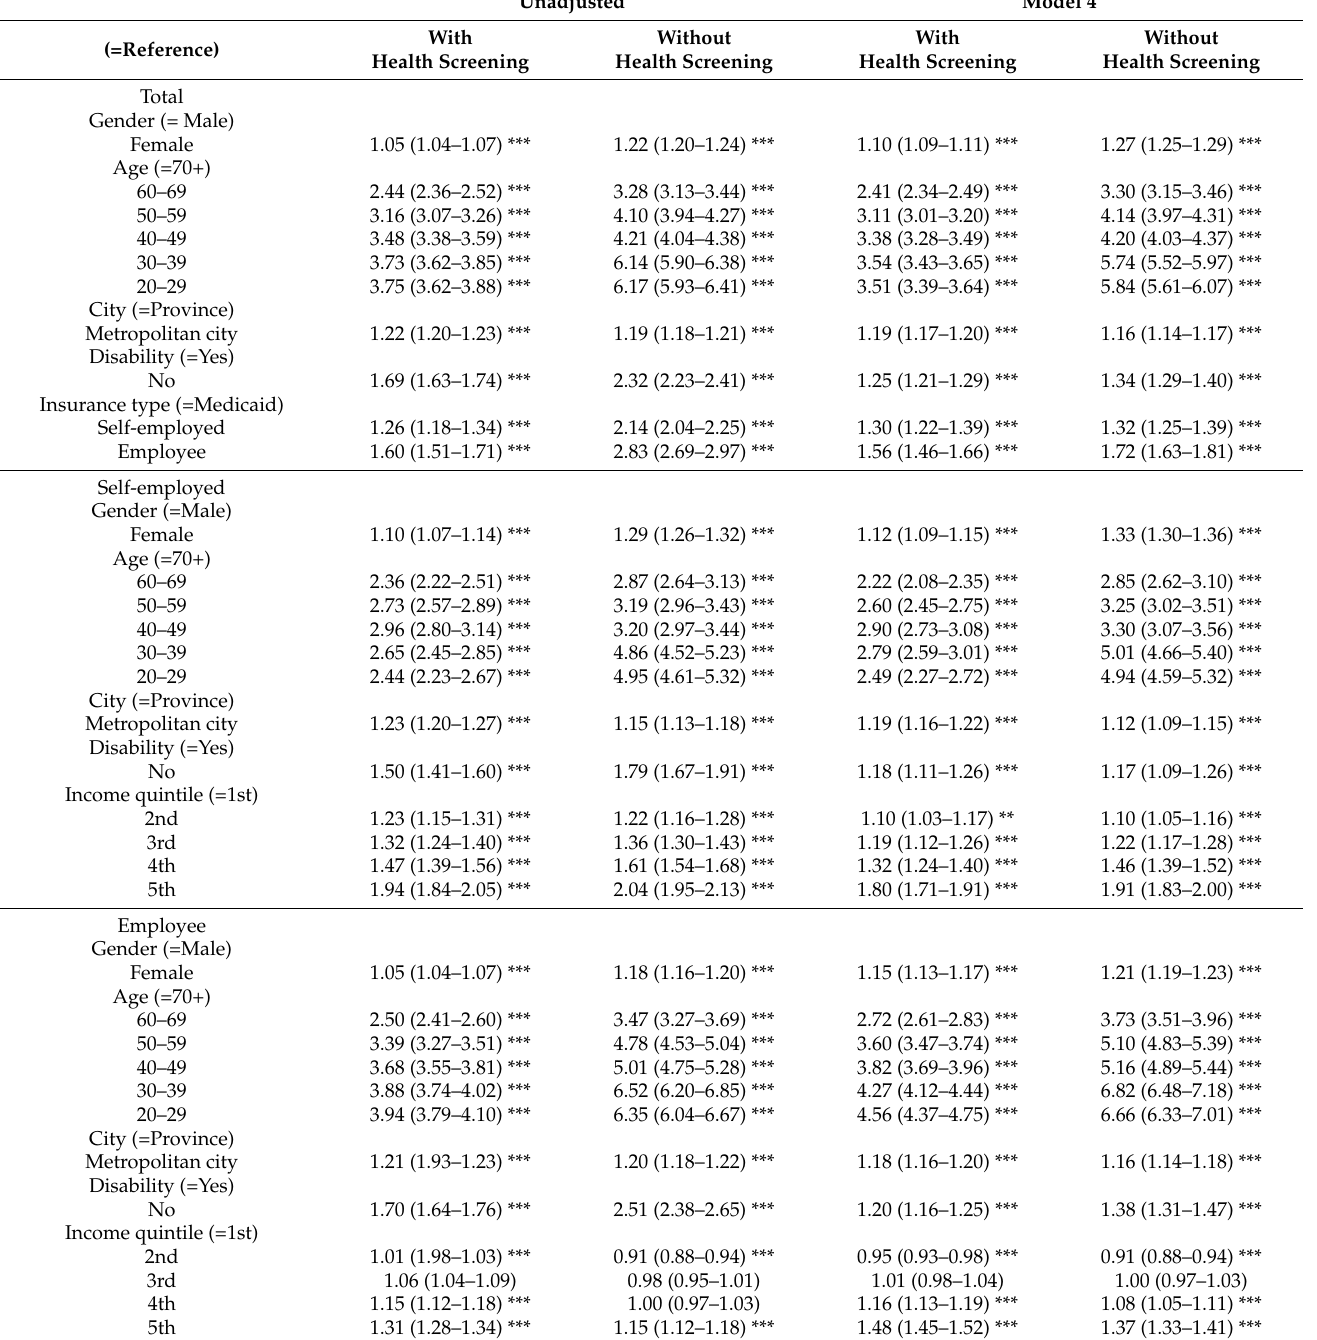
Table 4. Odds ratio (OR) and 95% confidence interval (CI) estimated from logistic regression models for dental scaling by insurance types in the